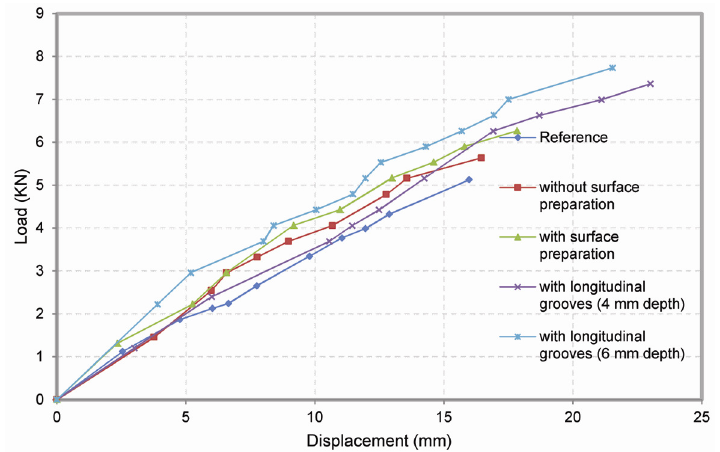
Fig. 20. Comparing the curves of load-displacement in reinforced specimen with one layer of GFRP